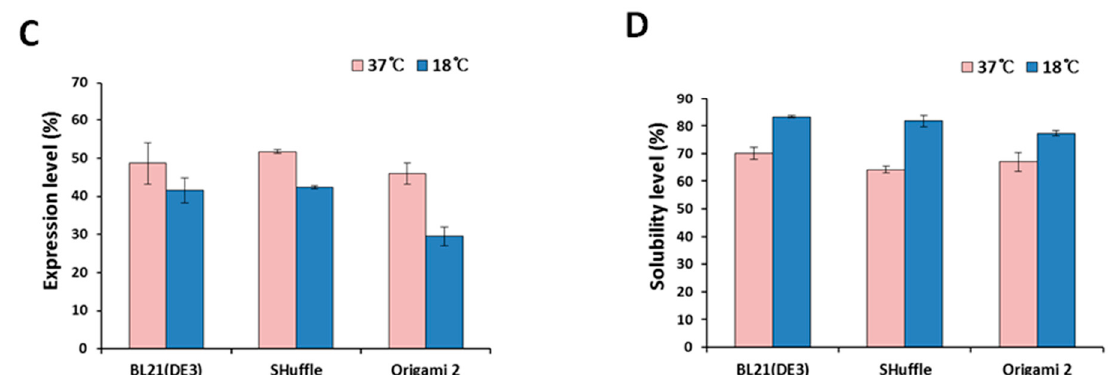
Figure 2. Expression and solubility of MBP-HER2(scFv)-PE24B in different E. coli hosts. Expression of the MBP fusion protein was induced by 0.5 mM IPTG at 37 °C ( A ) and 18 °C ( B ). The arrows indicate MBP-HER2(scFv)-PE24B (97.4 kDa). M, molecular weight size markers; C, total proteins of BL21(DE3) before IPTG induction (negative control); I, total proteins after IPTG induction; P, insoluble pellet fraction after cell sonication; S, soluble fraction after cell sonication. ( C ) Expression levels and ( D ) solubility levels at 37 °C and 18 °C for the three E. coli hosts. The expression and solubility levels were analyzed using the densitometry method and three replicate experiments. The expression levels (%) of MBP-HER2(scFv)-PE24B were calculated based on the density ratio of MBP-HER2(scFv)-PE24B to total E. coli proteins. Solubility levels (%) were calculated based on the density ratio of solubly expressed MBP-HER2(scFv)-PE24B to the total expressed MBP-HER2(scFv)-PE24B.